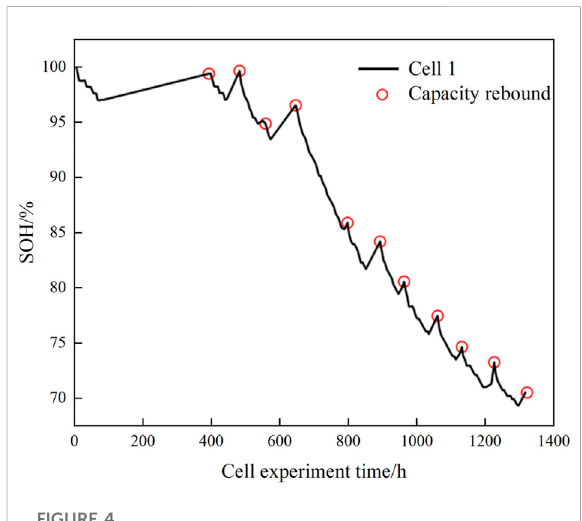
FIGURE 5 Cell two rest time greater than threshold cycle